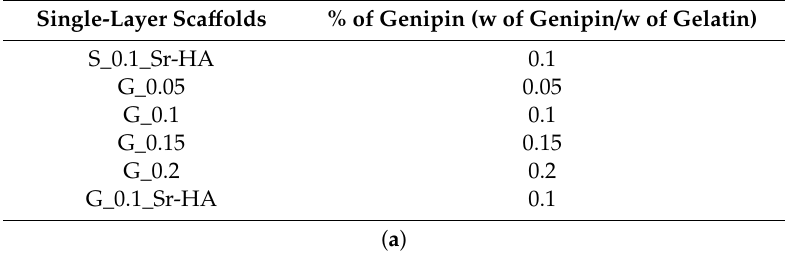
Table 1. Composition of the obtained ( a ) single-layer and ( b ) double-layer scaffolds.